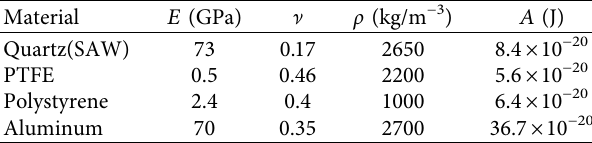
Table 2: Properties of materials [36].